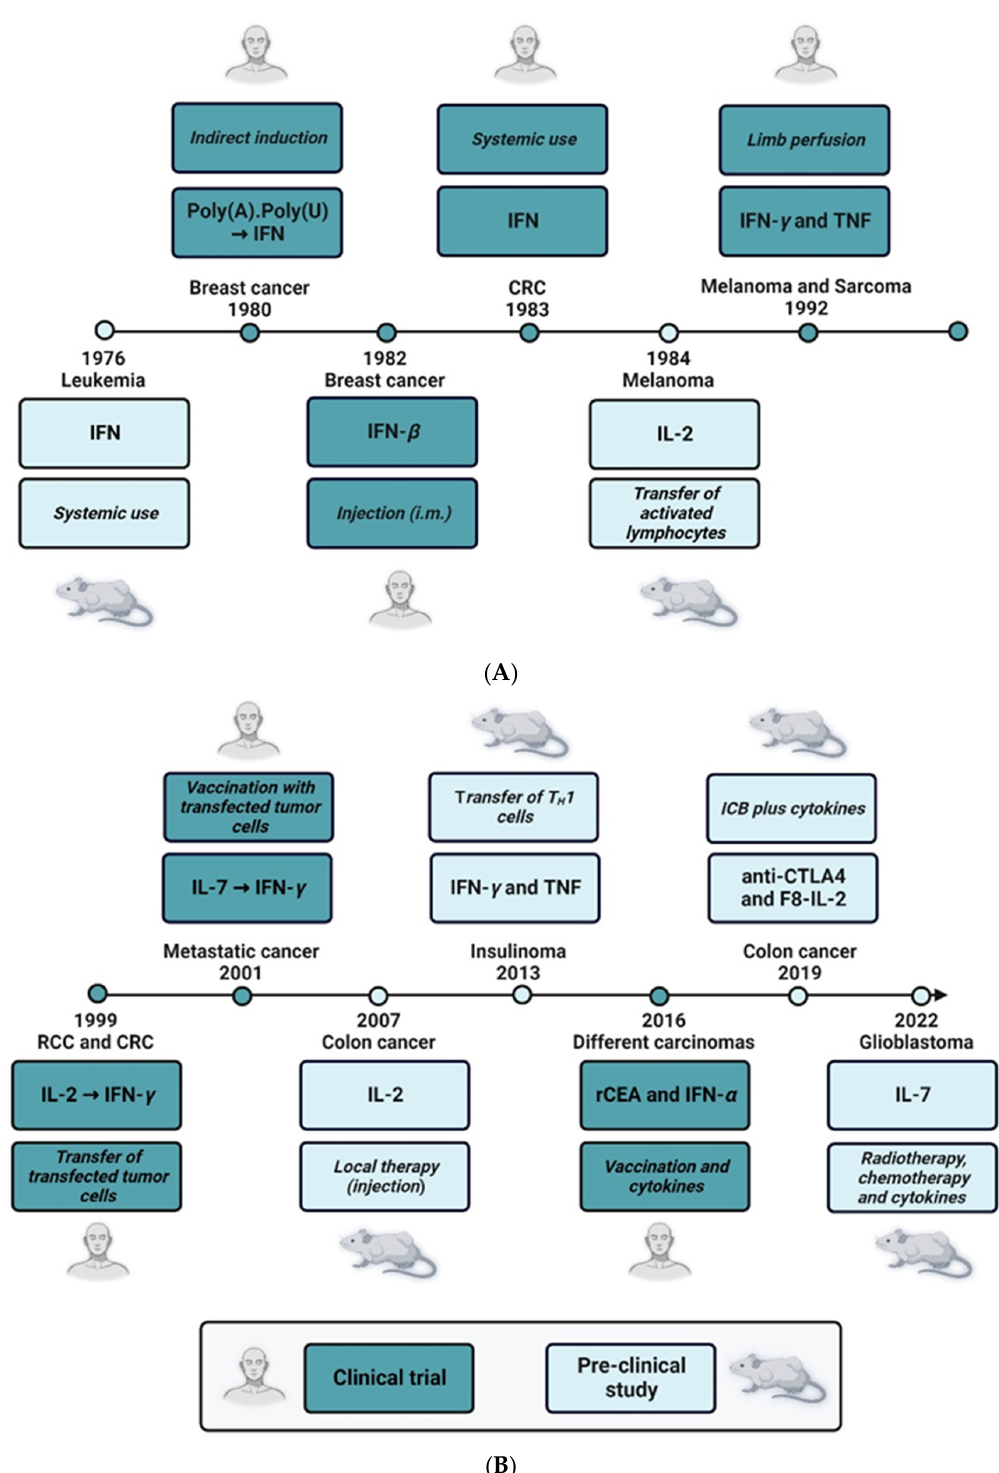
Figure 5. Timeline of cytokine-related cancer therapies. ( A ) 1976–1992. ( B ) 1999–2022. The time bar depicts the timely order of pre-clinical (light blue boxes) or clinical (dark blue boxes) therapeutic use of different cytokines, mainly interferons, or cytokines in combination therapy. The study designs, the administration routes, the use of genetically modified cells, the identity of the cytokines or therapeutic agents are stated in the respective boxes, and the targeted cancer types are stated either directly above or below the year of publication of the study. For references of the pre-clinical and clinical studies see in-text citations of chapter 3.